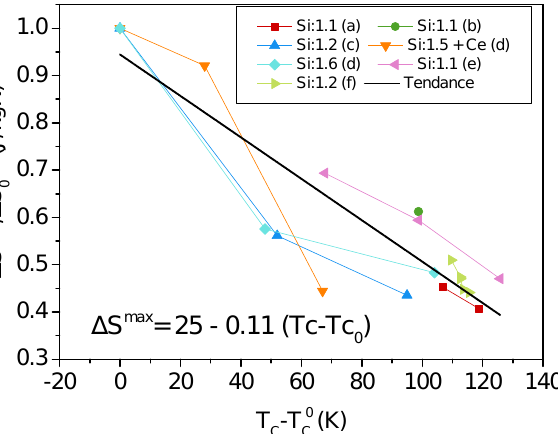
Figure 3. Relative magnetic entropy evolution as a function of T C for materials in which Fe iron has been substituted by Co, compared to the compound without Co. (a) [46], (b) [47], (c) [48], (d) [49], (e) [18], and (f)